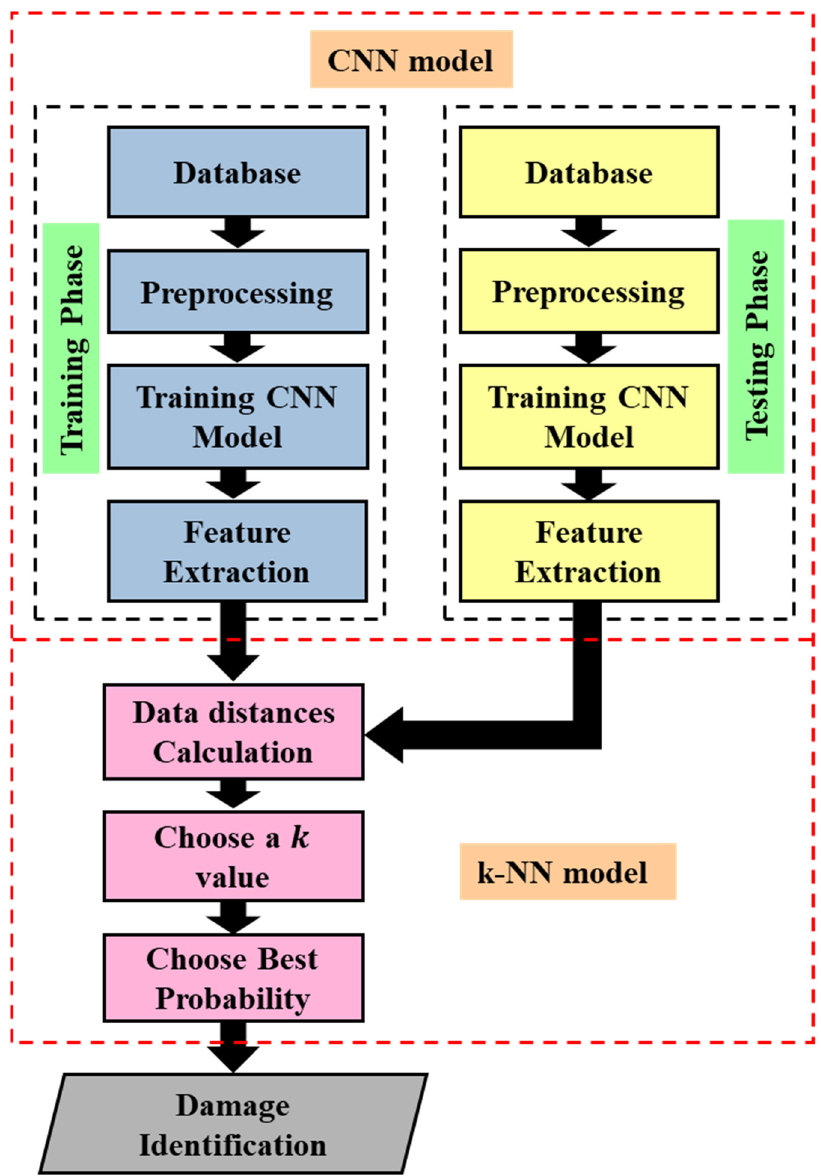
Figure 22. The Overall CNN + k-NN (ECNN) Flowchart.